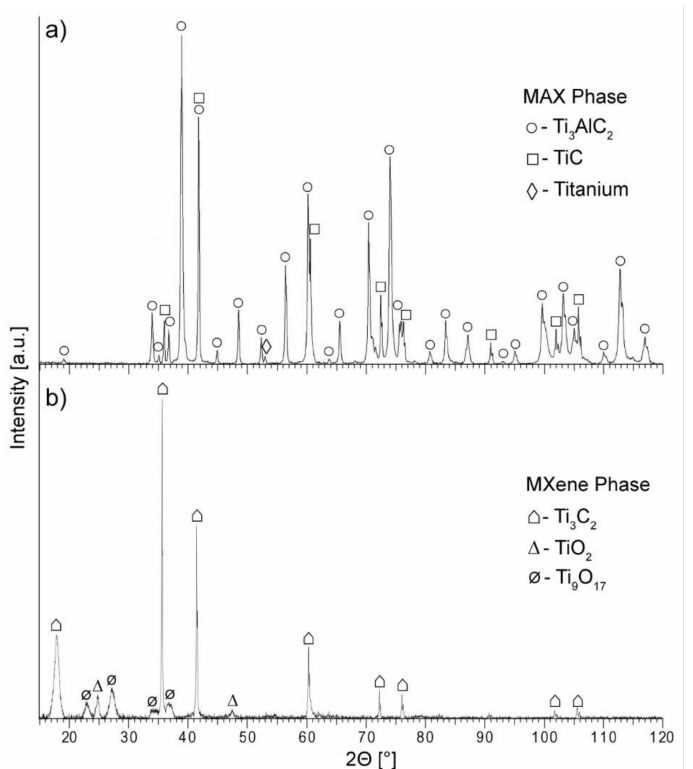
Figure 2. X-ray diffraction (XRD) patterns for ( a ) synthesised Ti 3 AlC 2 MAX phase, ( b ) Ti 3 C 2 MX- ene